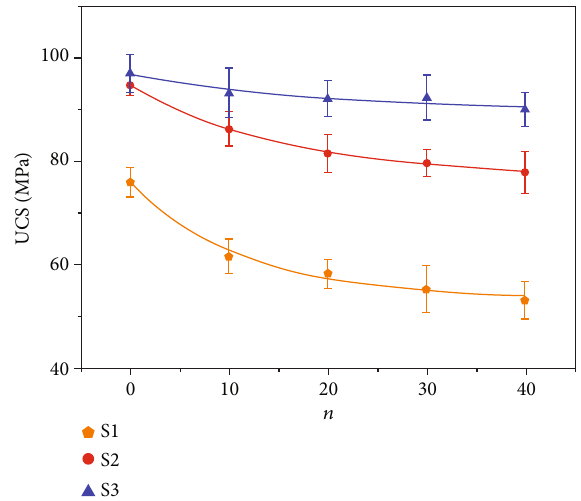
Figure 4: Variation in the UCS of tested sandstones versus the number of WD cycles.